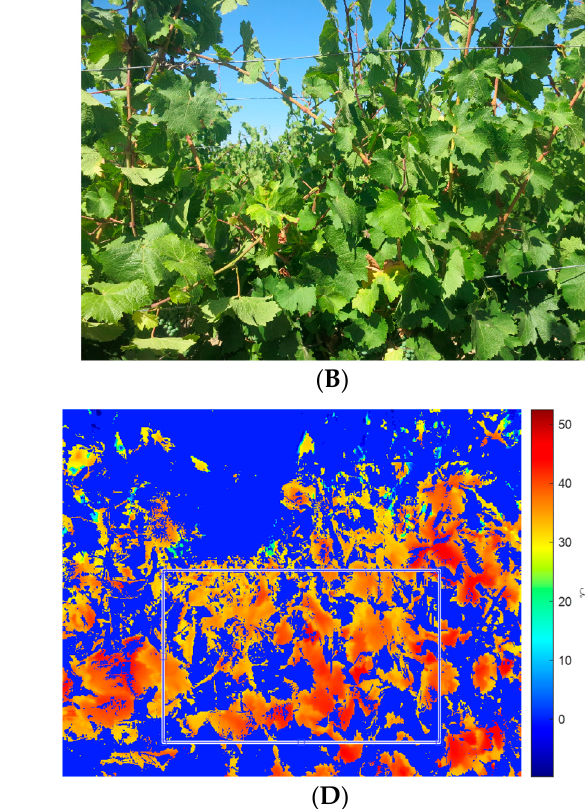
Figure 3. Thermal imagery and processed image of a sample grapevine canopy: ( A ) false color thermal image, ( B ) original RGB image, ( C ) canopy binary mask, ( D ) overlapped thermal image with selected rectangle ROI.